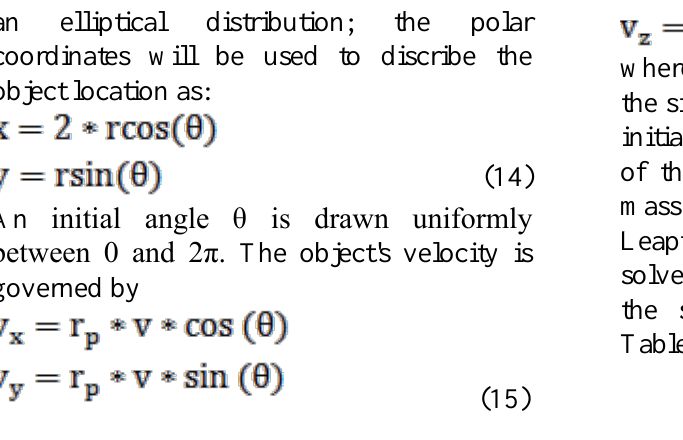
Table1: Parameters of simulation for elliptical distribution model under Newtonian gravity Number of Number of Total Velocity star Time step Radius Velocity Shape factor iteration mass dispersion particles 3000 0.00015 32128 5 1×10 5 30 random